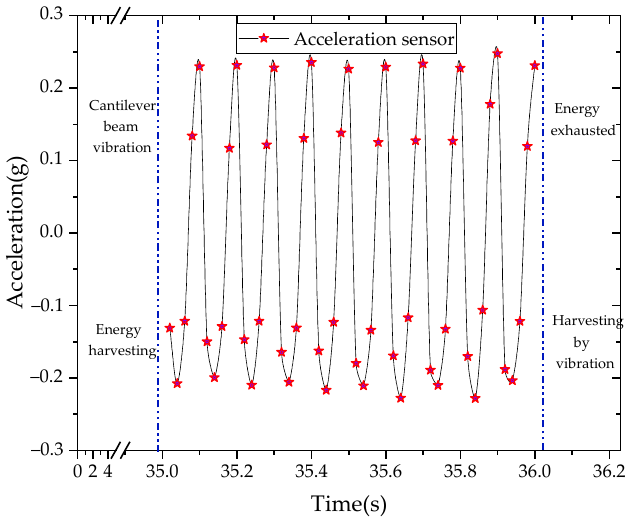
Figure 28. Acceleration sensor data.